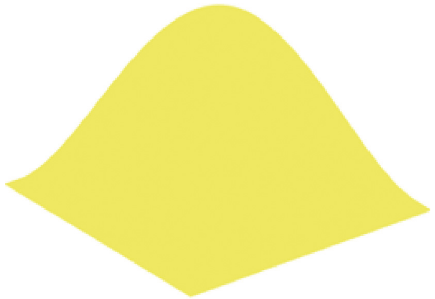
Figure 22: Sequence of